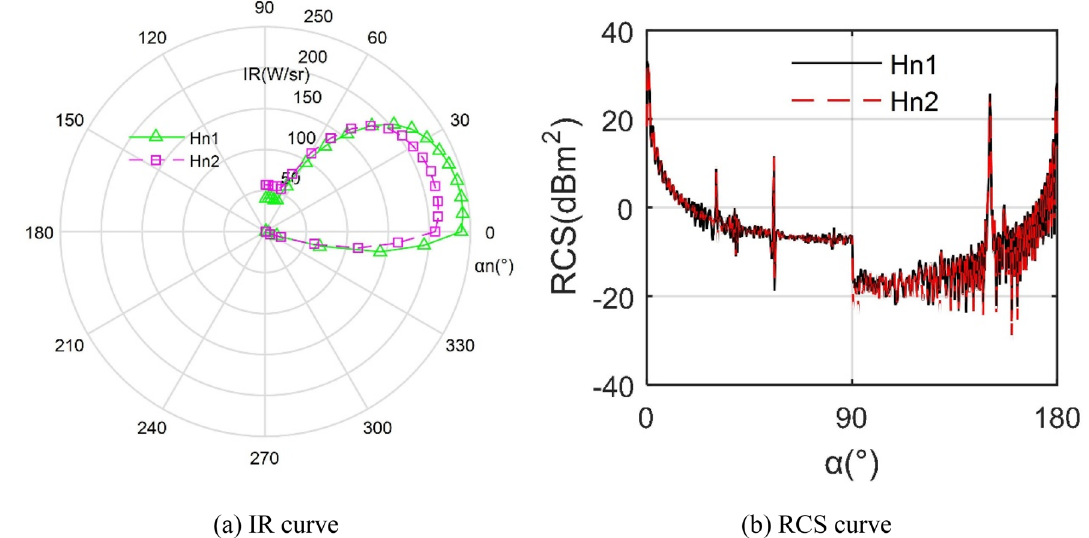
Figure 13. Effect of exhaust port height on aircraft stealth performance.